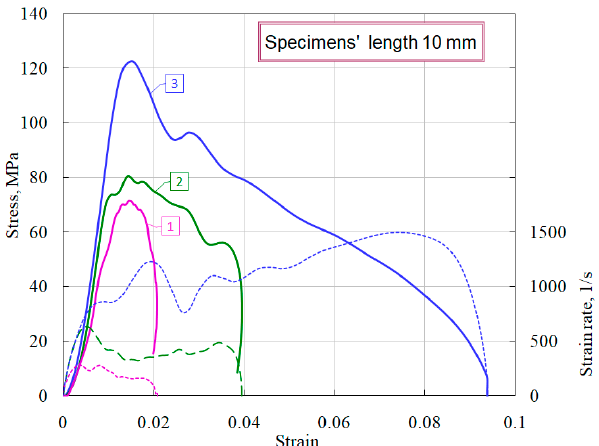
Figure 6. Deformation diagrams of ceramic specimens of optimal geometry under compression.